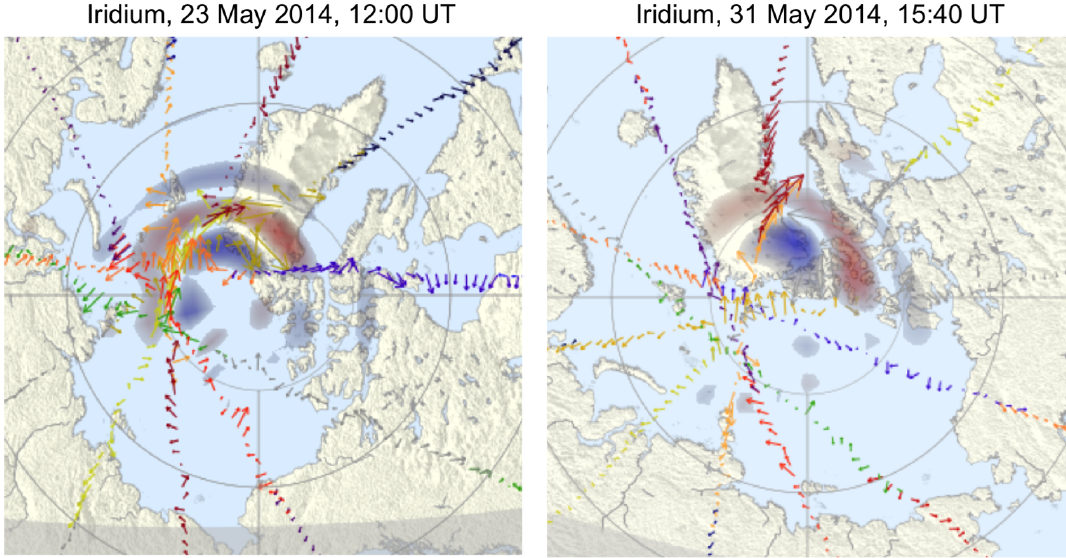
Figure 13. Plots of magnetic field deflection vectors along the tracks of Iridium satellites for the 10min intervals shown in Fig. 12. Local noon is at the top of the plots. Estimates of FAC sheets are shown as shaded bands like in Fig. 12.